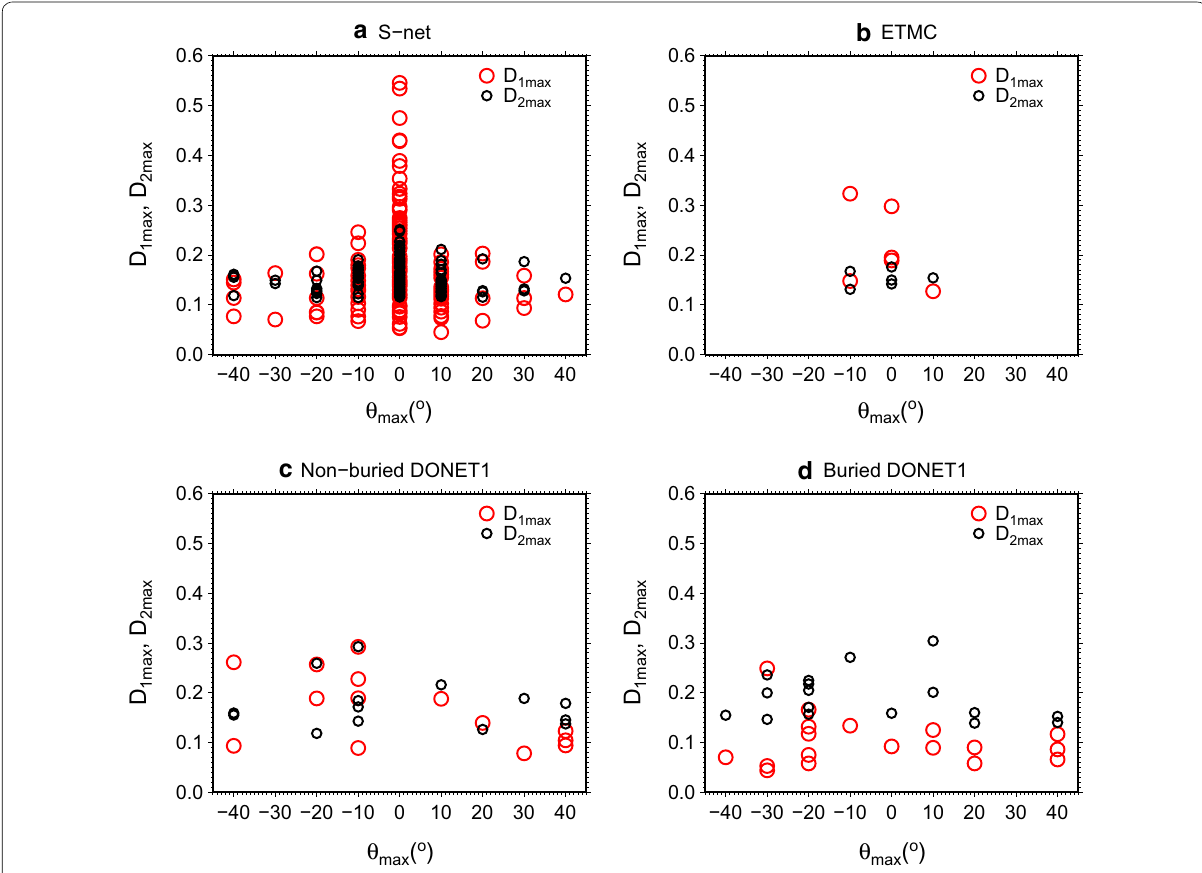
Fig. 4 Plot of θ max versus D 1max (red circles) and D 2max (black circles) for ( a ) S-net, b ETMC, c non-buried DONET1, and d buried DONET1